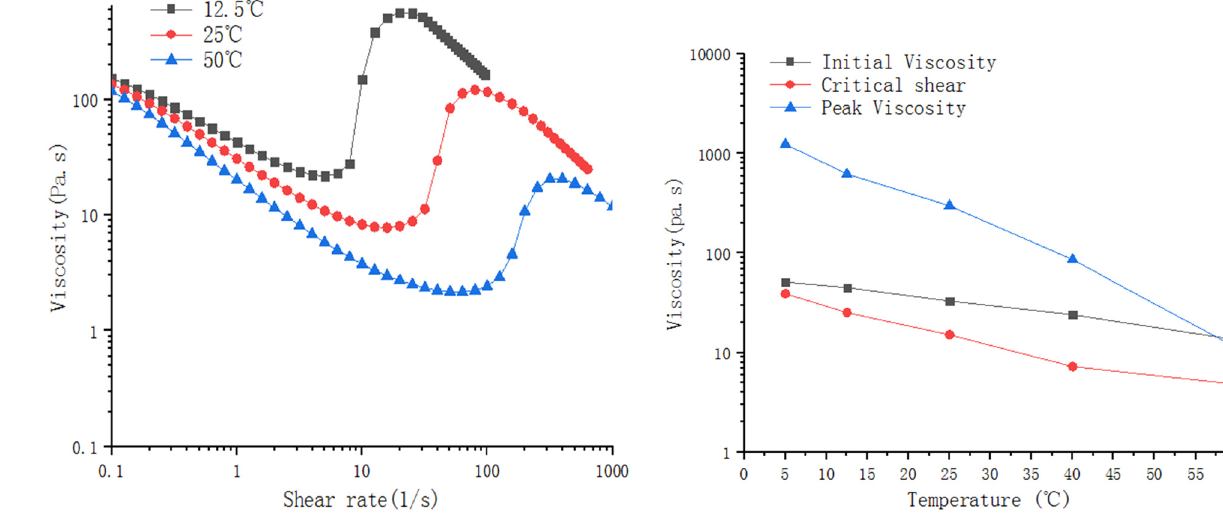
Figure 11: The steady - state viscosity - shear rate curves of the MWCNTs/SiO 2 – STF system at di ff erent temperatures.